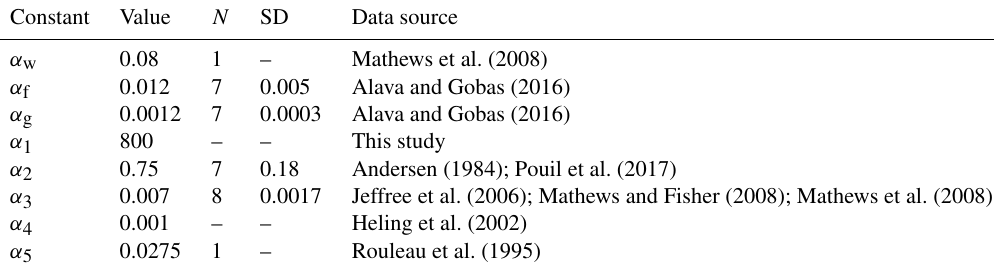
Table 1. Parameters in allometric relations, standard deviation (SD) of parameters and number of measurements N . Constant Value N SD Data source